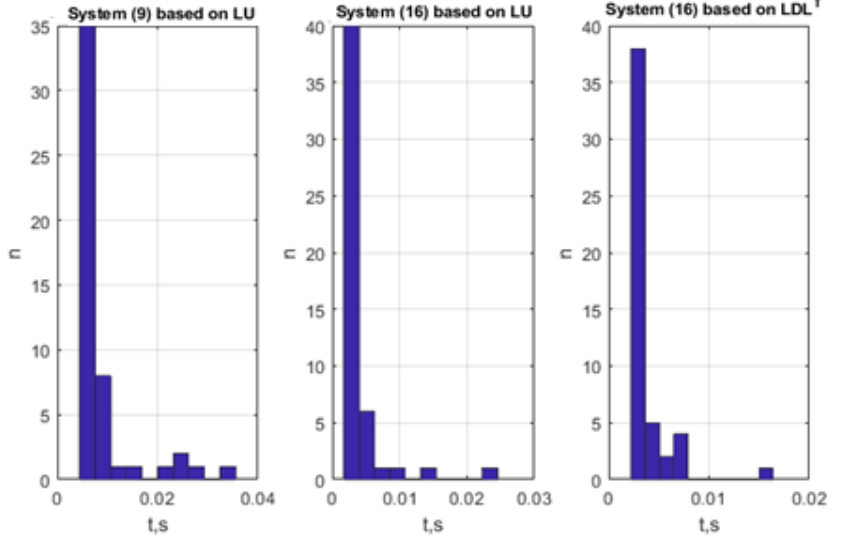
Figure 4. Histogram of the decision time.